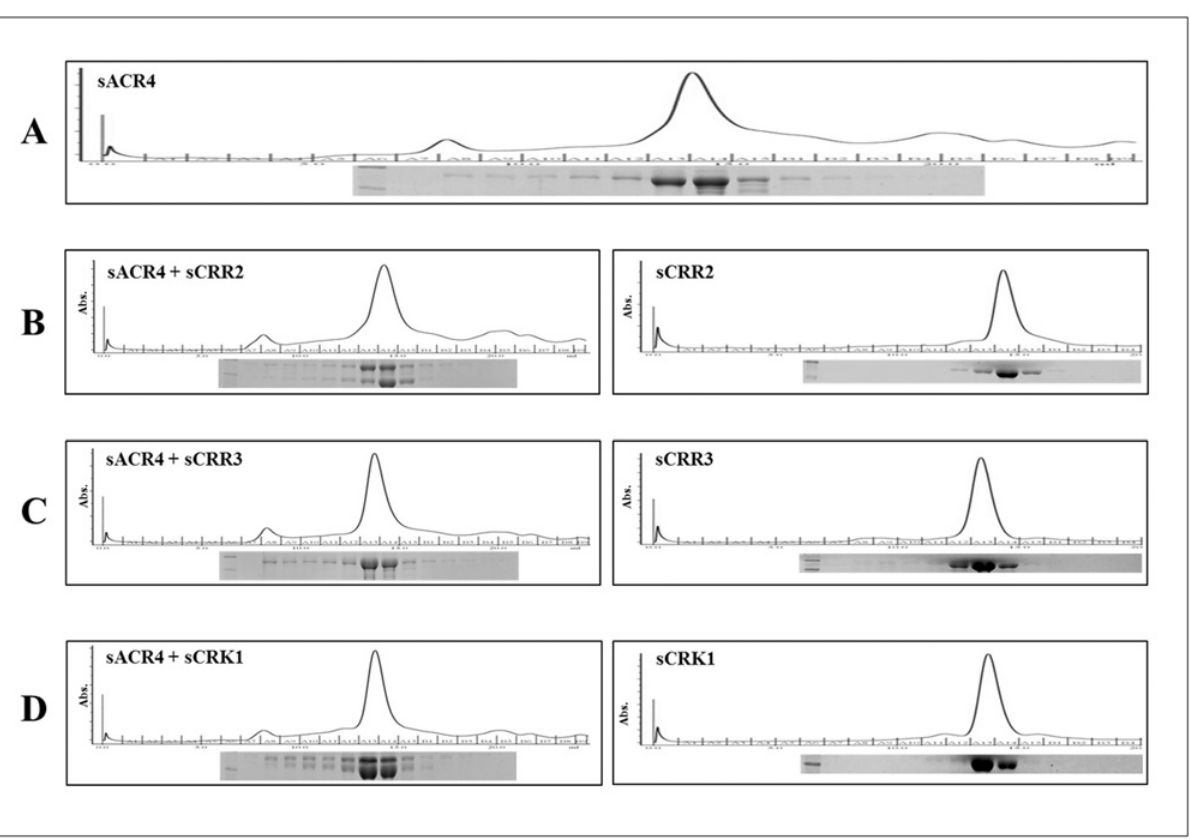
Fig 1. Gel filtration analysis of ICD interactions. Protein-protein interactions between the ICDs of ACR4 and the CRR binding partners were assessed by gel filtration on a Superdex G-200 column. (A) ACR4 elution profile demonstrating the protein primarily elutes as a monomer, but has the propensity to form higher order oligomers. (B-D) the elution profiles of the CRRs incubated alone ( right panels ) or with ACR4 ( left panels ). Insets depict 12% SDS-PAGE gels of eluted protein fractions.